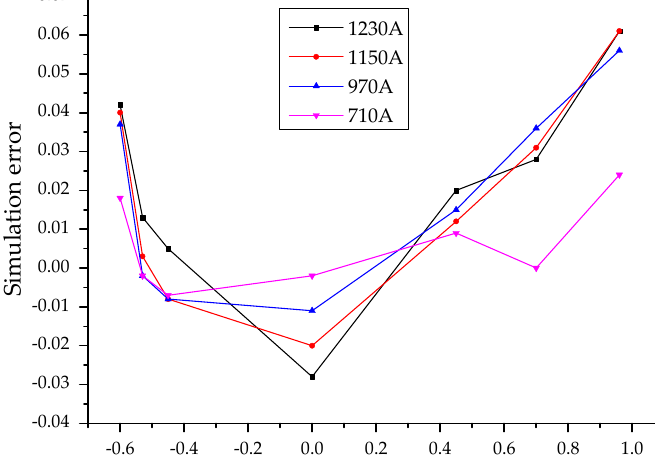
Figure 14. Comparisons between experimental and modelling results under different loads.